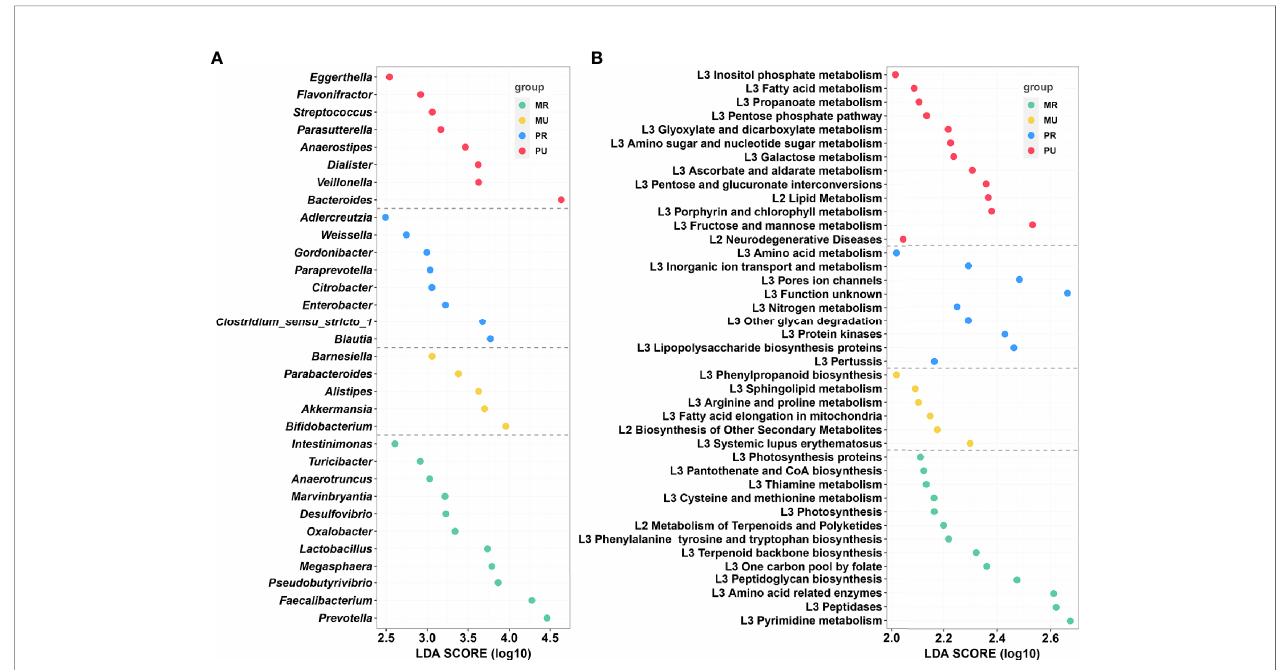
FIGURE 6 | LEfSe analysis and Kyoto Encyclopedia of Genes and Genomes (KEGG) assignments of the mountain rural (MR), mountain urban (MU), plain rural (PR), and plain urban (PU) groups. (A) LEfSe analysis identi fi ed the predominant taxons of each group. Green represents the bacteria speci fi c for the MR group, yellow represents the bacteria speci fi c for the MU group, blue represents the bacteria speci fi c for the PR group, and red represents the bacteria speci fi c for the PU group. (B) Presentation of the altered KEGG pathways in each group. Grouping was performed in the same way as in Figure (A) LDA scores were calculated by LDA effect size, using the linear discriminant analysis to assess effect size of each differentially abundant bacterial taxa (A) or KEGG pathways (B)